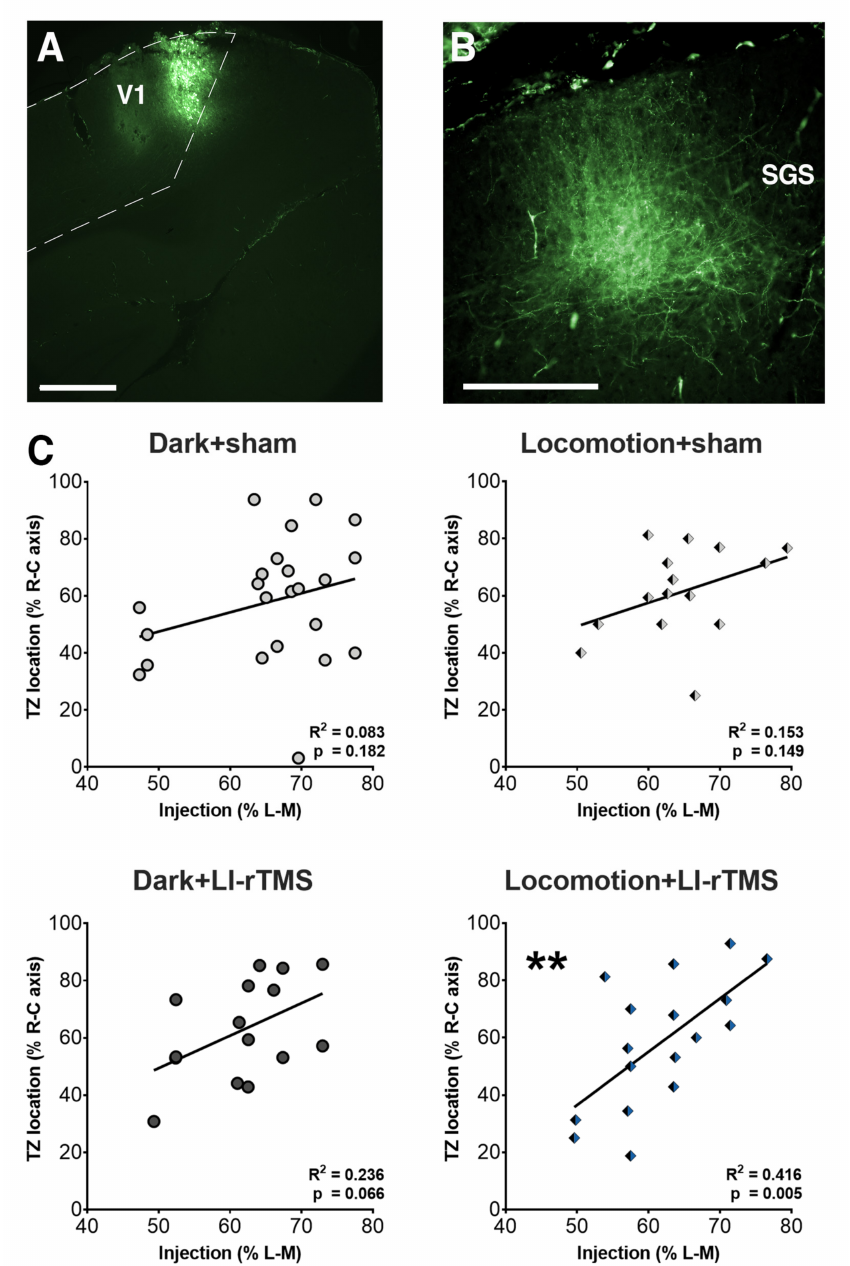
Figure 1. Linear regression analyses of injection and TZ location in ephrin-A2A5 -/- mice following chronic LI-rTMS. Sham or LI-rTMS was delivered to adult ephrin-A2A5 -/- mice for 14 consecutive days in a red-light room (dark) or with free access to a running wheel (locomotion). Example image of ( A ) injection site in V1 (scale bar = 250 µ m) and ( B ) anterograde TZ labelling in the stratum griseum superficiale (SGS) in the SC (scale bar = 100 µ m). ( C ) The location of fluorescent injections in V1 was expressed as a percentage of the lateromedial axis (L-M) of the hemisphere width, and TZ location was expressed as a percentage of the rostrocaudal axis (R-C) of the whole length of the SC. The coefficient of determination of the linear relationship between injection site in V1 and TZ location in the SC is presented. ** p < 0.01, linear regression